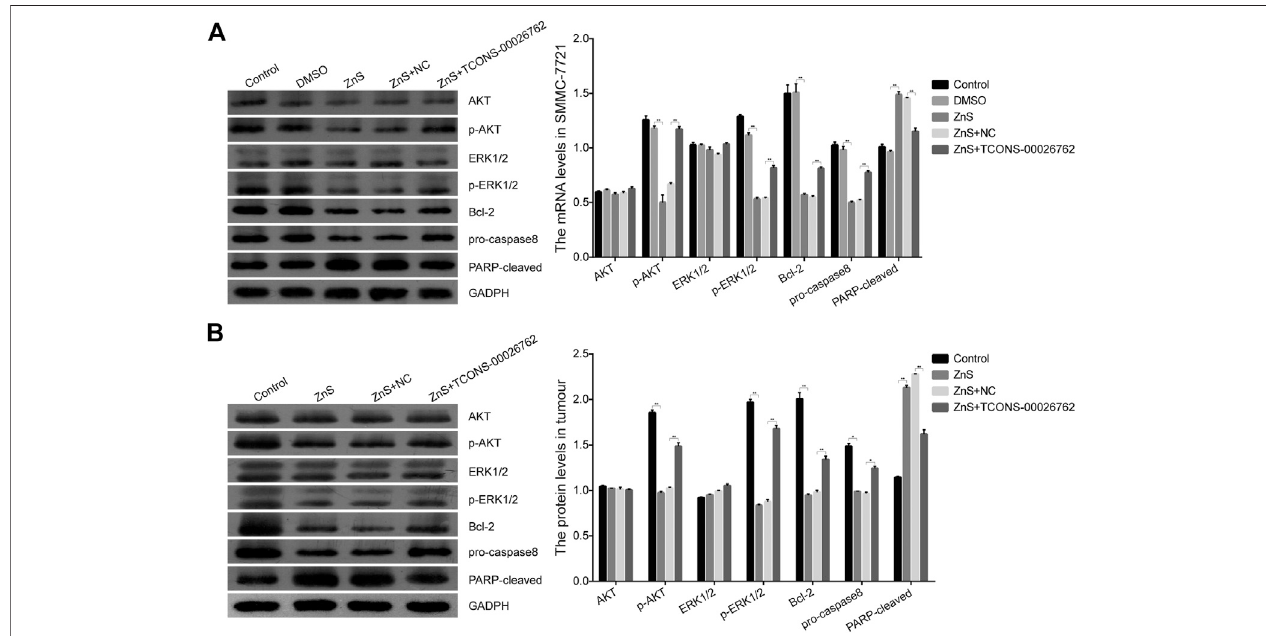
FIGURE5| Theexpressionlevelsofapoptosis-relatedproteinsinSMMC-7721cells (A) andtumortissue (B) .Eachtreatmentwasreplicatedthreetimes.Errorbars represents mean ± SD, *, p < 0.05, **, p < 0.01.